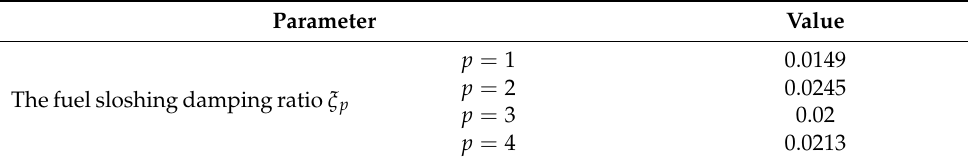
Table 3. Simulation parameters of liquid